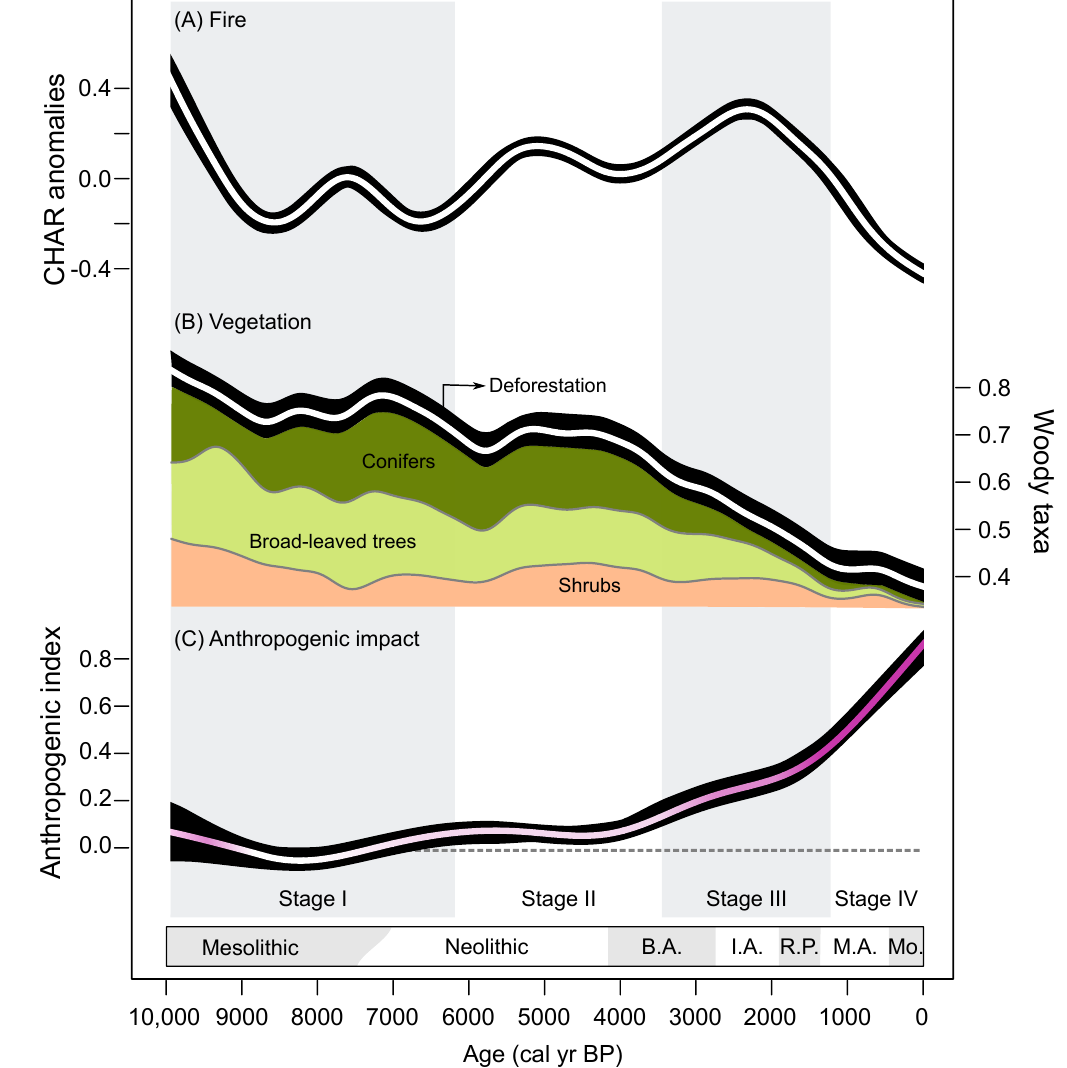
Figure 4. Holocene trends in fire, vegetation and anthropogenic impact in the Alpine sub-region. ( A ) Regional biomass burning as estimated by a GAM applied to the charcoal data from the sub-region ( B ) Vegetation openness inferred from woody-to-herbaceous pollen taxa. The relative proportion of conifers, broad-leaved trees and shrubs is shown. ( C ) Anthropogenic index as a function of time. The pink shading represents the total anthropogenic index-to-ruderal taxa ratio. The arrow shows the onset of pronounced deforestation depicted in Figure 7. In all cases, the black shading depicts 95% confidence intervals for the estimated